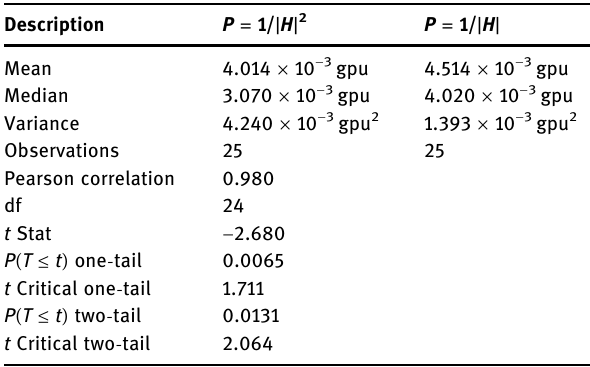
Table 4: t - Test: Paired Two Sample for Means using the samples of the mean errors of the benchmark derived from the adjustments based on weights ( 8 ) and ( 9 )